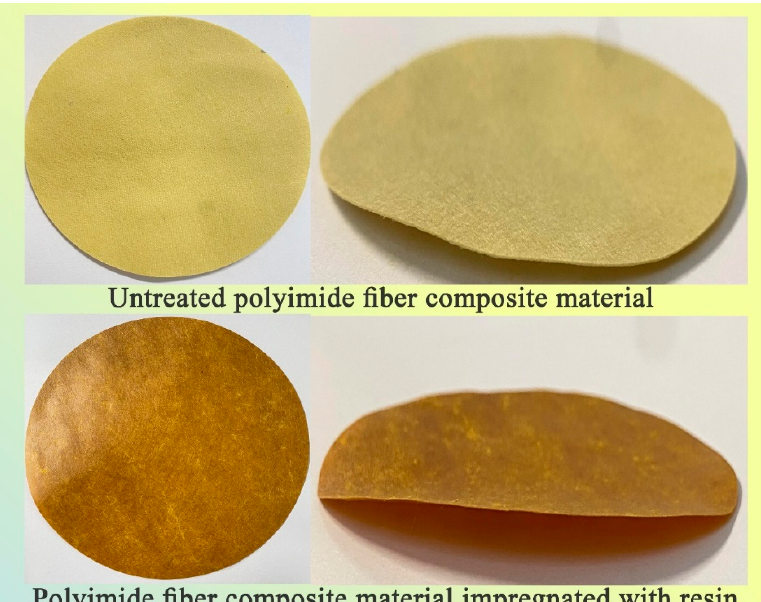
Figure 7. Polyimide fiber composite before and after work-up.